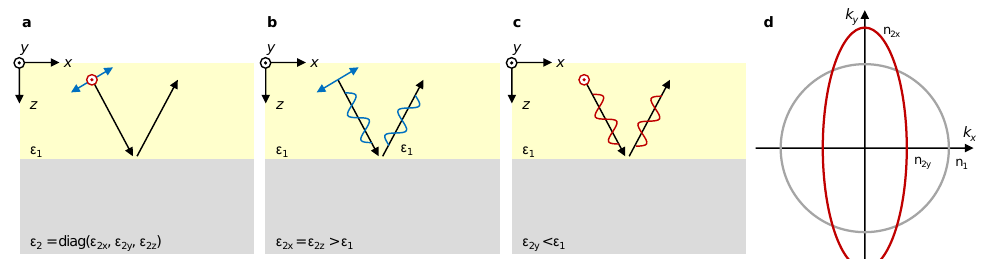
Figure 2. Reflection at an interface between isotropic (permittivity ε diag( ε 2 x , ε 2 y , ε 2 z )) media. ( a – c ) Schematic of the reflection under ( a ) general polarization, ( b ) p polarization, and ( c ) s polarization. ( d ) Equifrequency curves of the isotropic and anisotropic media, the interface between which supports the handedness-preserved reflection under circularly polarized incidence.